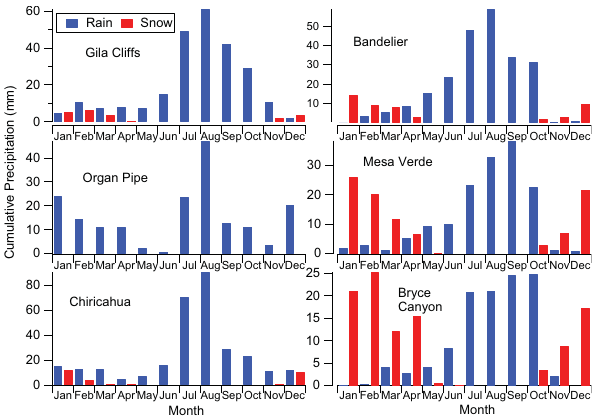
Fig. 7. Average monthly precipitation accumulation at the six NADP/NTN sites over the data ranges shown in Table 1.